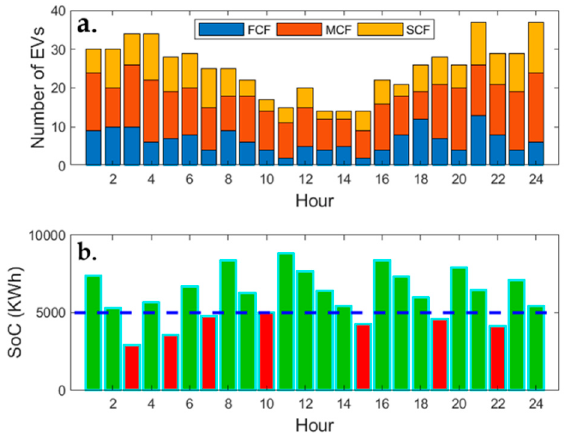
Figure 4. The charging demands and the SoC of EVCS #17. ( a ) Illustrates the number of EV arrivals at EVCS #17 in one day, where the total number is represented by arrivals at the three types of the charging facilities. ( b ) Shows the SoC of EVCS #17 in the same day, where the availability of energy at the station is represented by the green color and the station’s requirement to request a BESS unit swap from the BESS plant is represented by the red color.